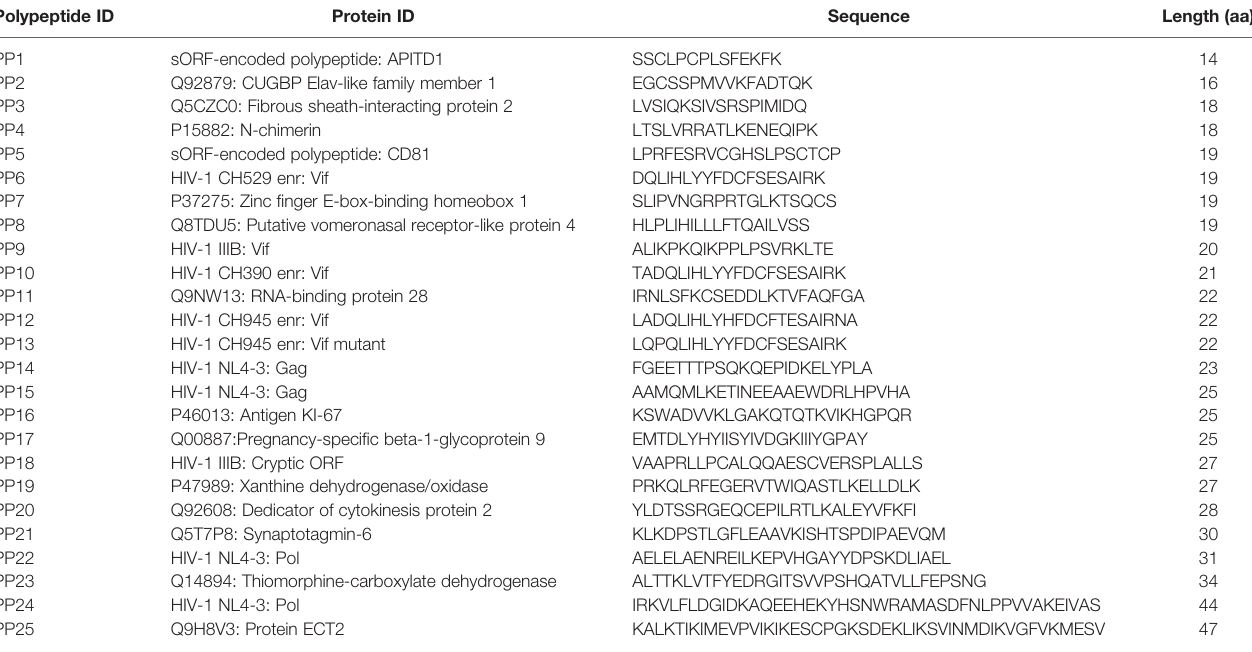
TABLE 1 | Synthetic polypeptides subjected to in vitro proteasomal digestion. Polypeptide